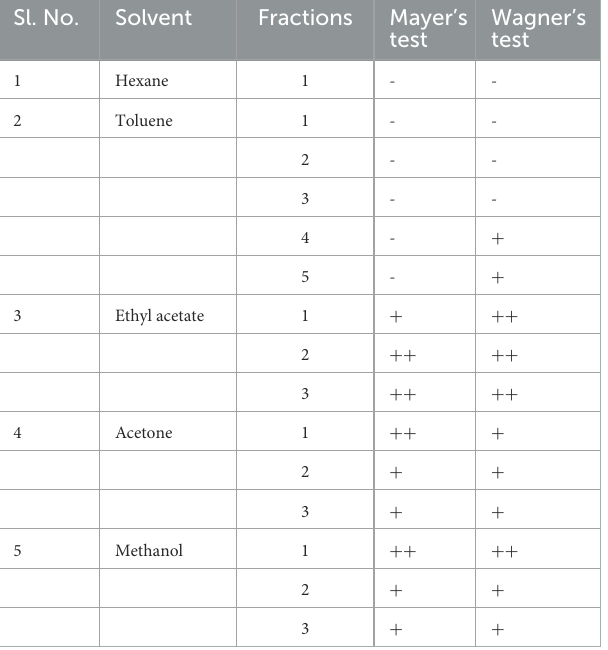
TABLE 1 Qualitative alkaloid tests by Mayer’s and Wagner’s reagents for vasicine. Sl. No.